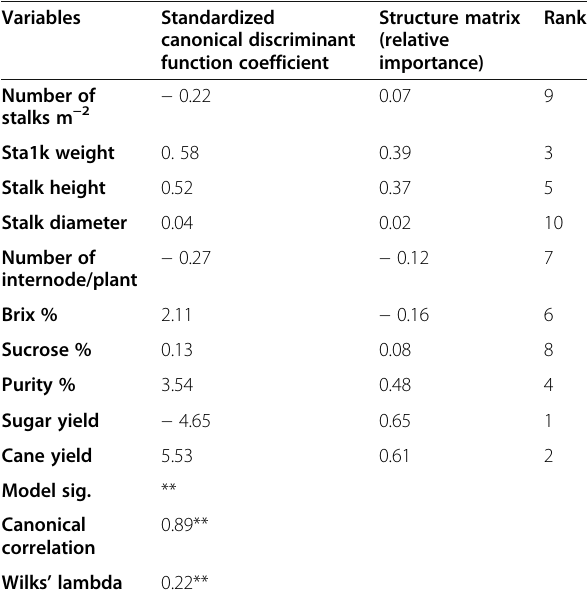
Table 7 Standardized canonical discriminant function coefficients and structure